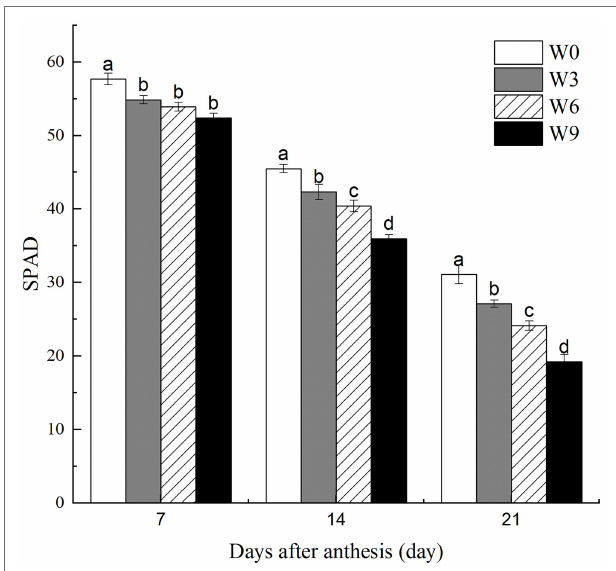
FIGURE 2 | SPAD values of wheat flag leaves under varying waterlogging treatments. Data were collected at 7, 14, and 21 days after anthesis. W0 = control, W3 = 3 days of waterlogging, W6 = 6 days of waterlogging, W9 = 9 days of waterlogging. Vertical bars represent the mean of each treatment (six replicates across two years) ± SE (standard errors). Means carrying the same letter are not significantly different at the 5% level.